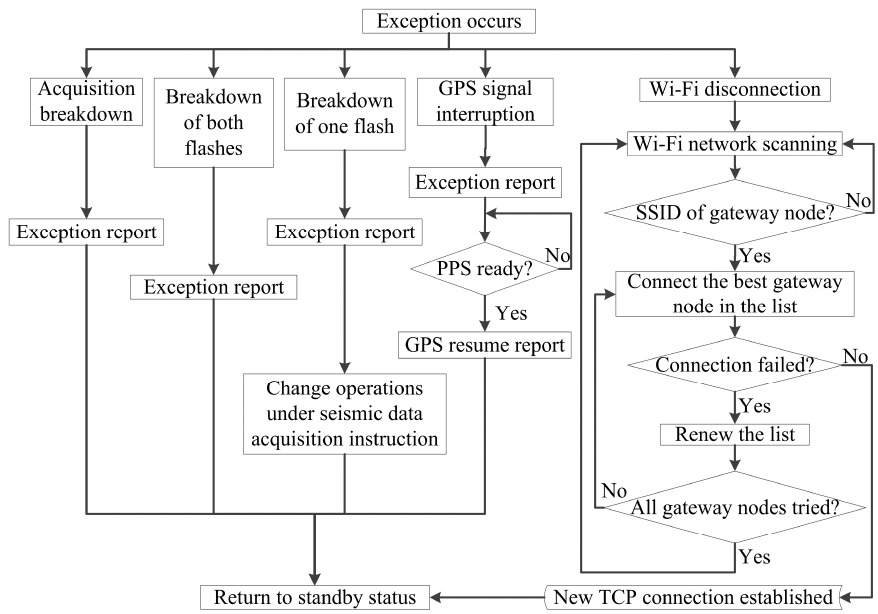
Figure 6. Workflow of collecting node reliability mechanisms.